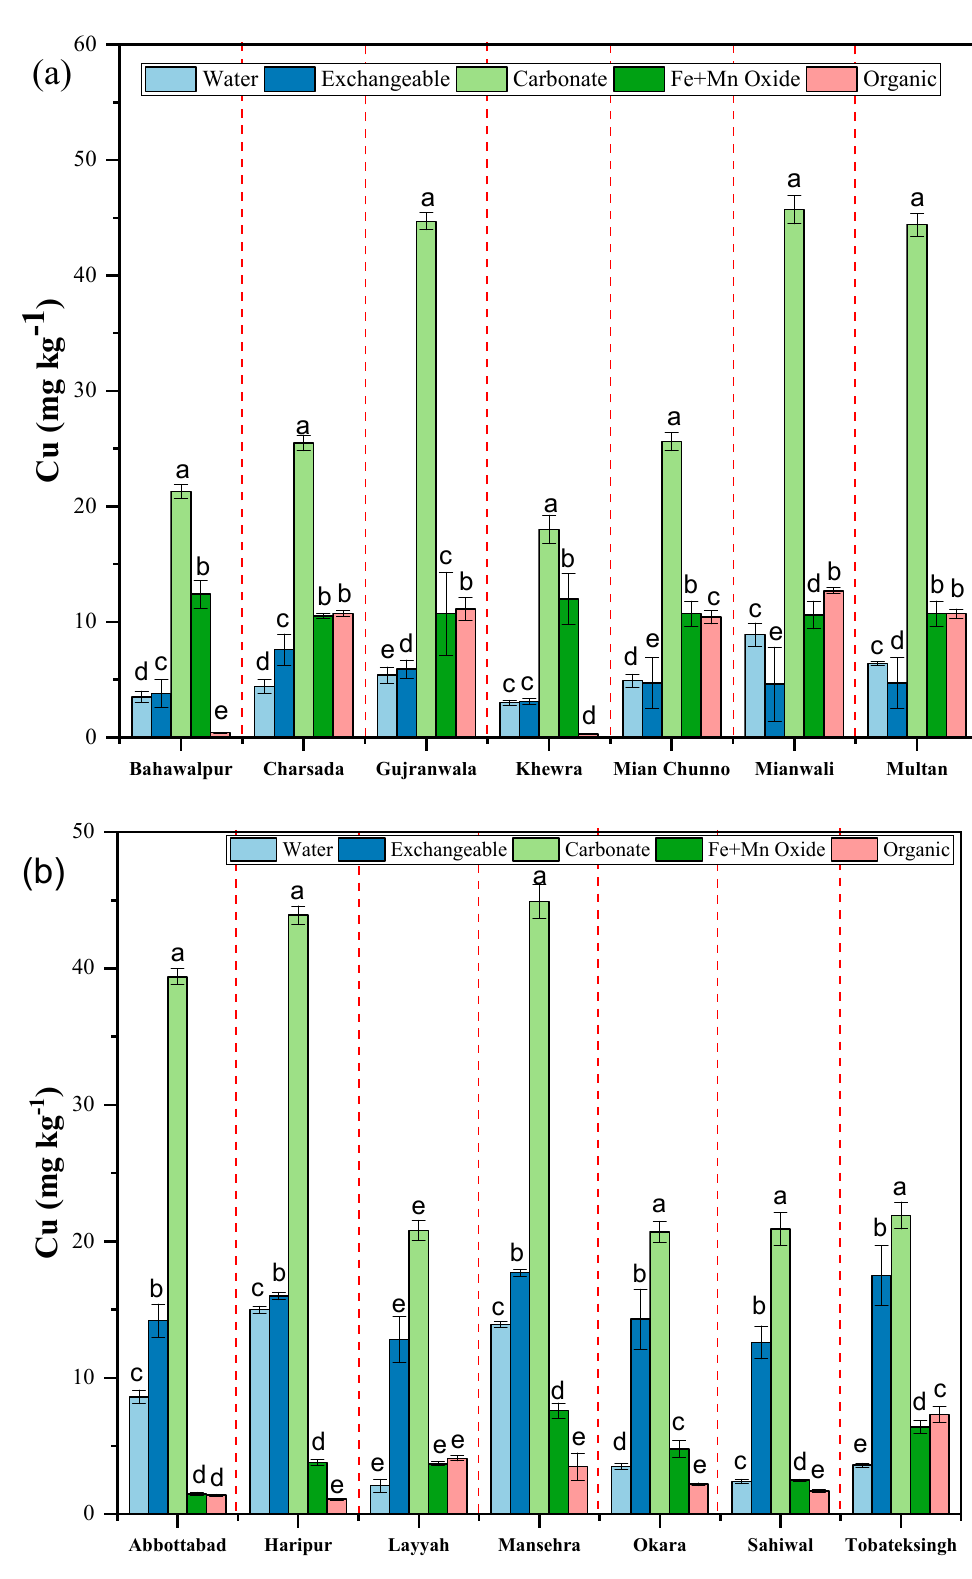
Figure 3. Fractionation of Cu in saline ( a ) and non-saline soils ( b ). (1) LSD test was used to determine significance difference among different fractions of Cu. Alphabets indicate the statistical difference among metal fractions. 2) The red lines separate the agricultural area. Table 5. Fractionation of Mn in saline and non-saline soils.